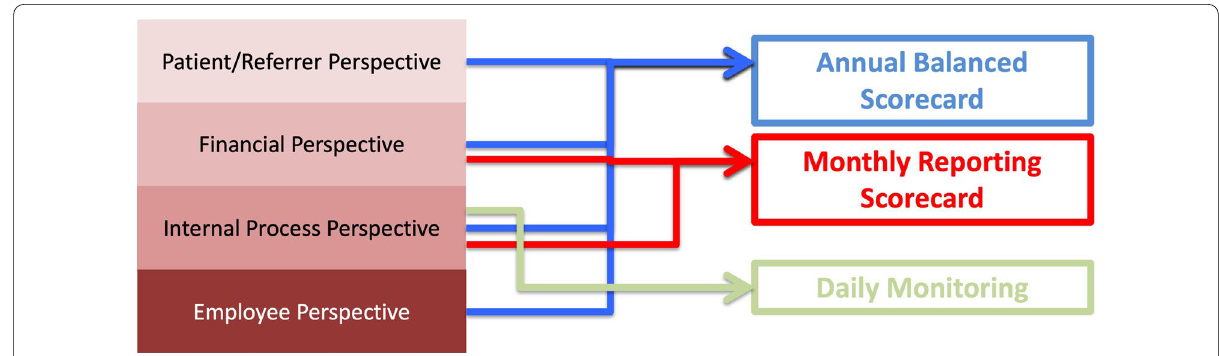
Fig. 1 Deriving the scorecards from the four key perspectives